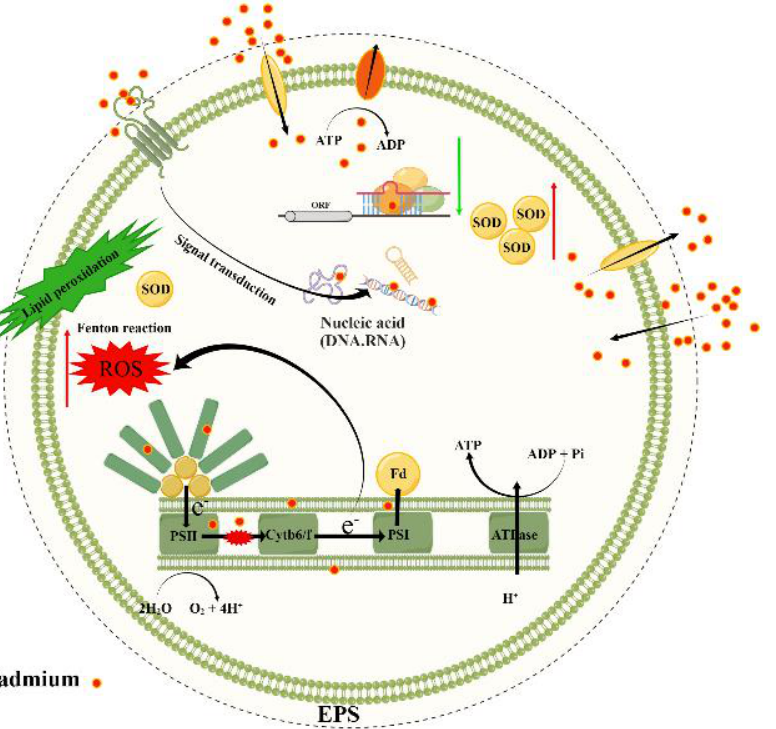
Figure 9. A conceptual model of the mechanism of cadmium action on Synechocystis sp. PCC 6803.